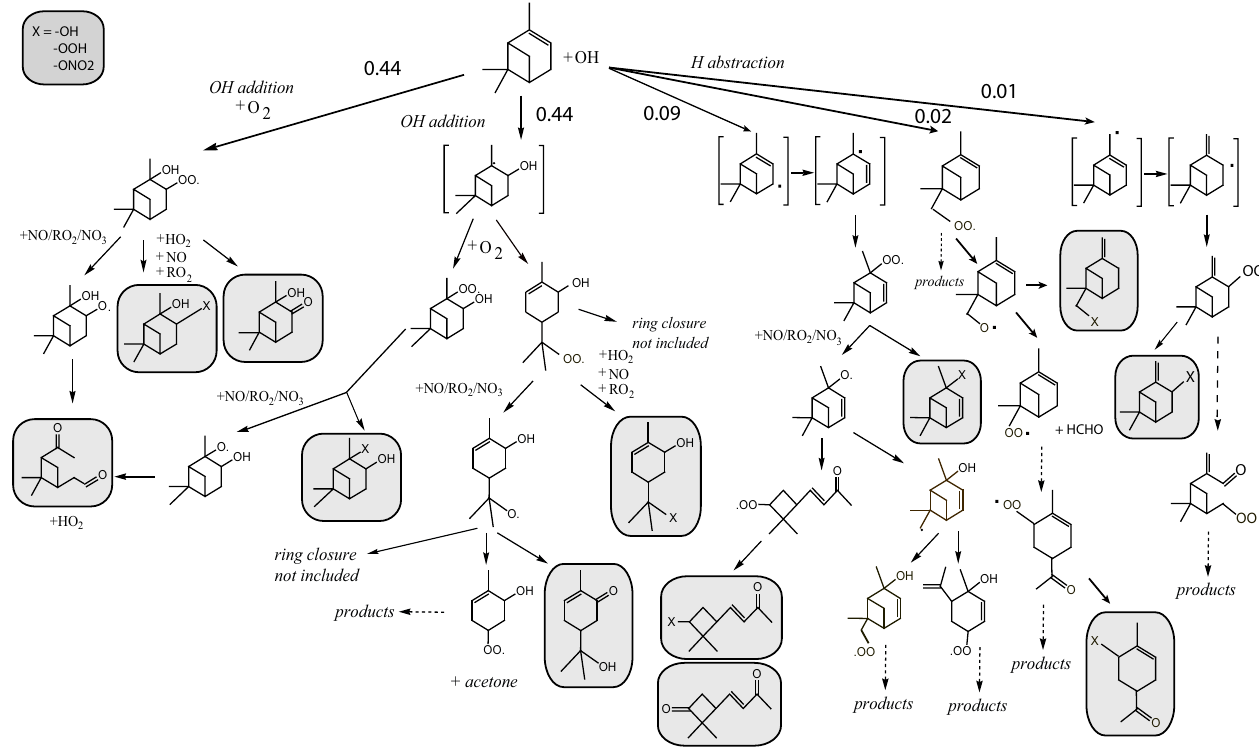
Fig. 2. First oxidation steps of the α -pinene oxidation by OH as represented in GECKO-A. Framed compounds represent stable